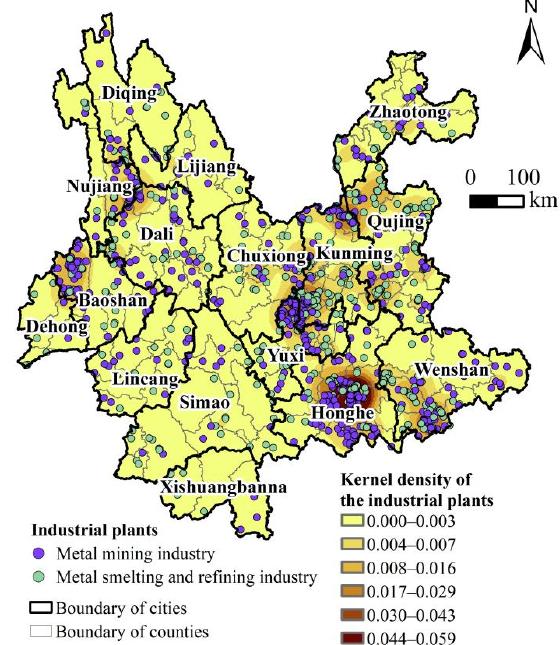
Figure 4 . Spatial distribution of the industrial